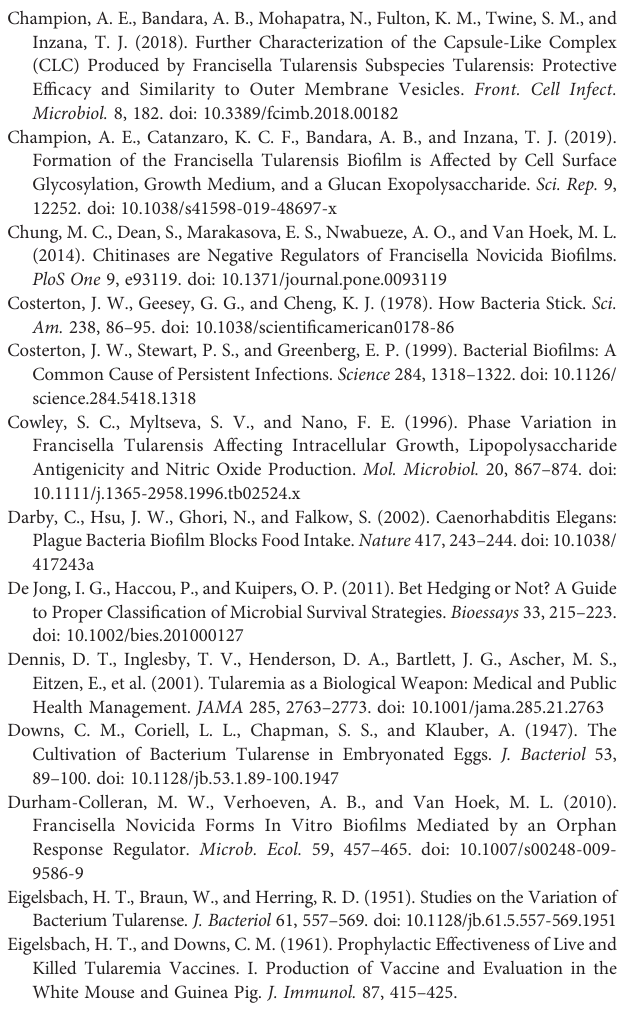
necessary. Each dot represent a single well in an experiment. The least squares slope relating growth to bio fi lm is indicated by m. (B) Colony forming units were determined for samples that were either negative (black bars) or positive (grey bars) for bio fi lm formation by crystal violet staining at the time indicated. Error bars represent the standard error of the mean. N.D. indicates that nodata were obtained at the time of sampling. Supplementary Figure S2 | Stochastic bio fi lm formation is observed at 25 o C. (A) OD 600 values for bio fi lm formation as assessed by crystal violet staining are displayed attheindicated timepost inoculation.LVSwas growninCDMin a96-well plate. (B) LVS was grown at 37 o C in CDM then replica plated. Progeny were grown for 1 day at 25 o C and bio fi lm formation was assessed using crystal violet stain. The red bar indicates the median value. Supplementary Figure S3 | Flattened cell morphology was observed in some instances. The bio fi lm of LVS bio fi lm was sampled at day 5. Image displayed is representative from multiple independent experiments. Supplementary Figure S4 | Fully virulent Type A and B isolate progeny maintain the ability to form bio fi lm upon sub-culture. Bio fi lm formation was assessed by crystalvioletstainingat7dpostinoculationinFRAN244andFRAN255(TypeAand B isolate, respectively). Prior to staining, the original plates (top) were sub-cultured by replicate plating to create progeny plates (bottom). Progeny were assayed for bio fi lm development at 24 h post inoculation. Representative images are shown.